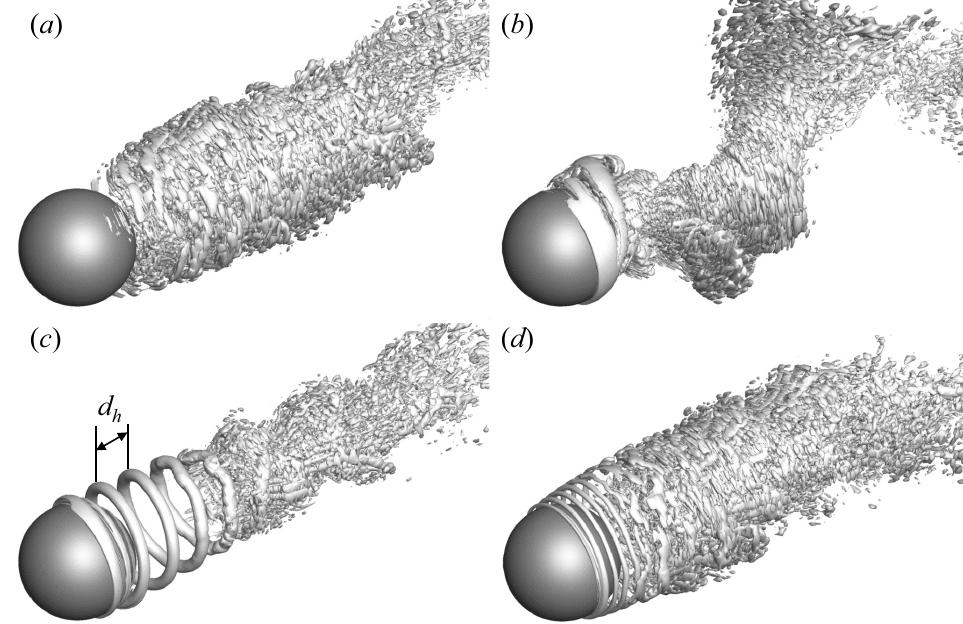
Figure 8. Instantaneous three-dimensional vortical structures in the turbulent wake of the sphere iden- tified using the λ 2 method [46] with various forcing frequencies f ∗ ( V 0 / u ∞ = 0.2): ( a ) uncontrolled flow; ( b ) f ∗ = 0.25; ( c ) f ∗ = 1.5; ( d ) f ∗ = 5.0.